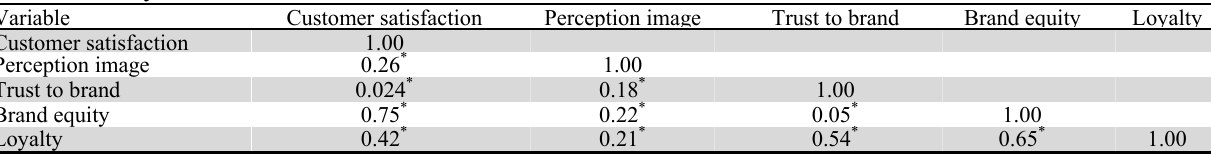
The summary of Pearson correlation